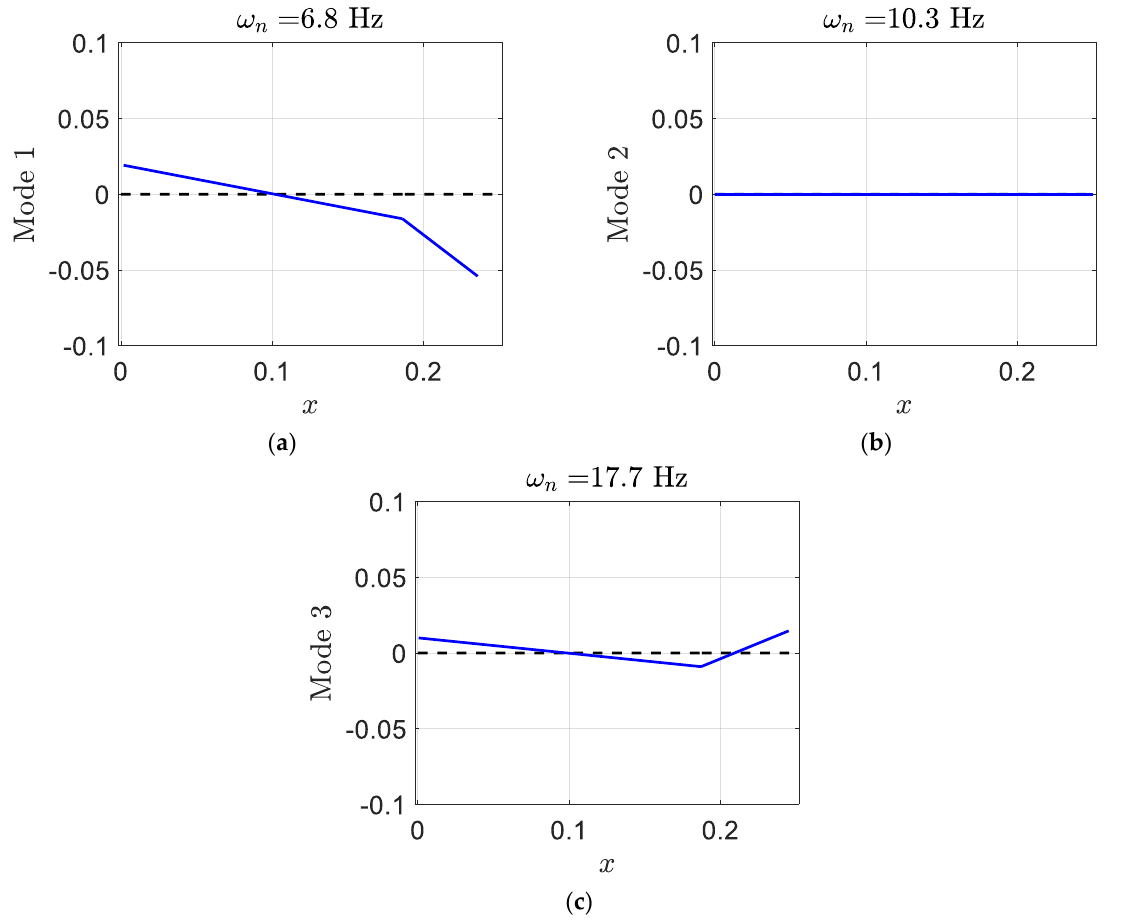
Figure 13. The smart blade unsteady plunge − pitch − control mode shapes at 𝑈 = 10 m s⁄ : ( a ) 𝜔 𝑛 = 6.8 Hz ; ( b ) 𝜔 𝑛 = 10.3 Hz ; ( c ) 𝜔 𝑛 = 17.7 Hz